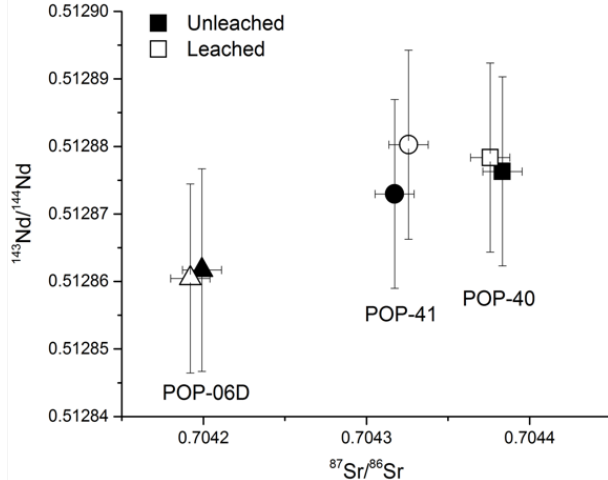
Figure A1: Sr–Nd isotope ratios of leached and un- leached digestions of a pumice (POP-06D) and two lavas. Results are indistinguishable within uncertain- ties. Error bars are 2 SE for Sr isotopic ratios, and 2 SD for Nd isotopic